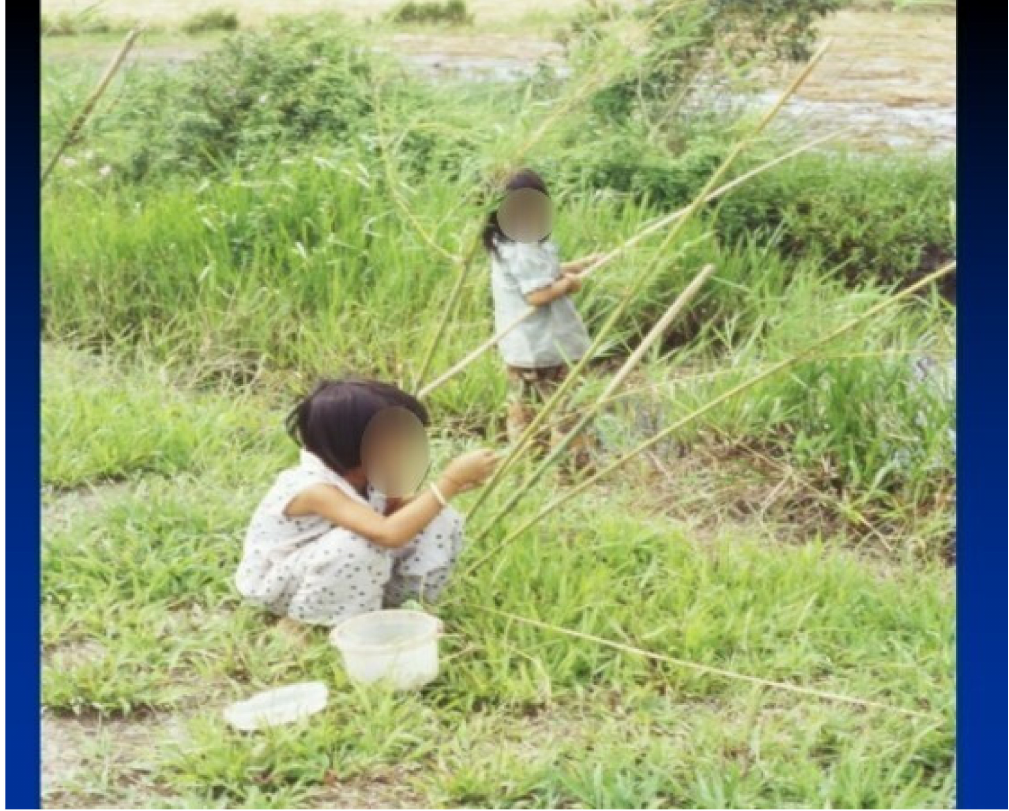
Figure 17. Catching even small fish in the wetlands of the Mekong Delta (Vietnam) can be an important addition to family nutrition. Source: Edward